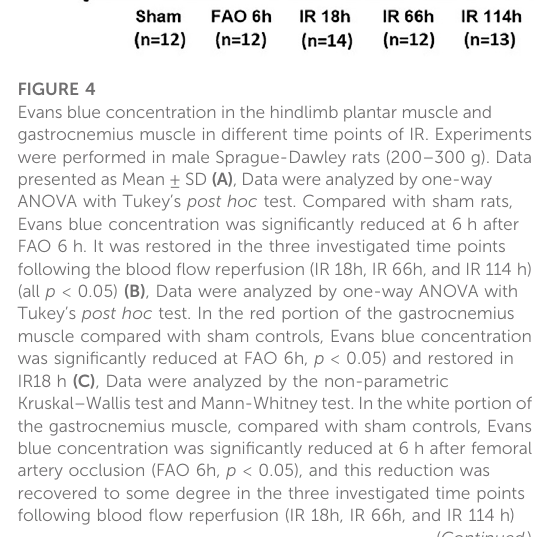
Unless speci fi ed, the data in this study were presented as the mean ± standard deviation (SD). The SPSS for Windows version 26.0 was utilized for all statistical analyses. Kolmogorov-Smirnov test was applied to evaluate the normality, and Leven ’ s test was used to assess the equality of the variance. Once the data met the standard of normal distribution and equal variance, one-way ANOVA was applied to compare the differences in BP and HR responses among the groups (Sham, IR 18 h, IR 66 h, and IR 114 h). As appropriate, Tukey ’ s post hoc test was applied to compare the differences between speci fi c groups. If the data did not meet the standard of normal distribution and equal variance, e.g., data on the MAP response, baseline HR and Evans blue concentration in the white portion of the gastrocnemius muscle, non-parametric Kruskal – Wallis test, and Mann- Whitney test were applied. A p -value less than 0.05 was considered statistical signi fi cance.